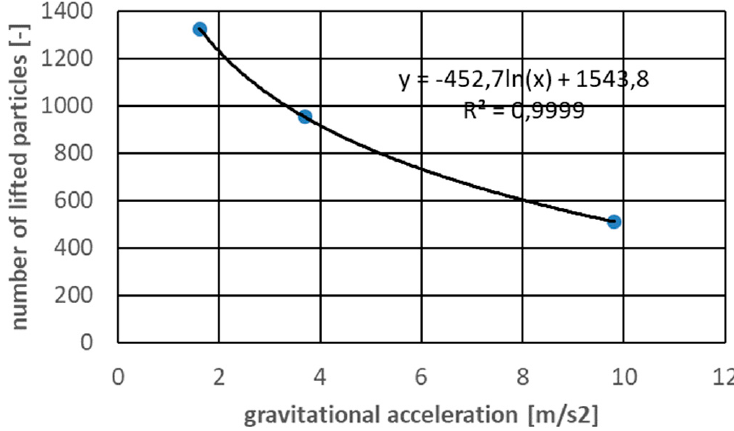
Figure 17. Number of lifted particles in different gravity conditions.